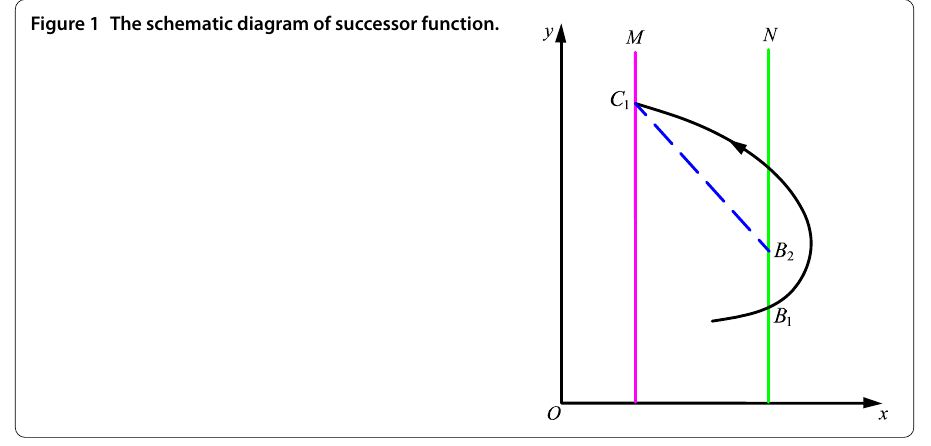
Figure 1 The schematic diagram of successor